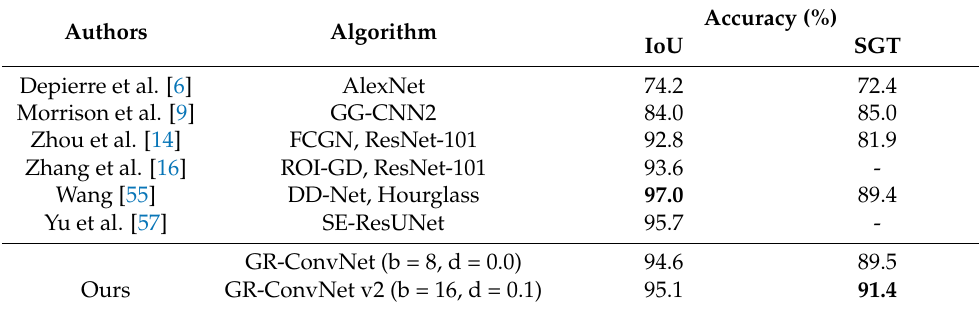
Table 5. Comparative results on the Jacquard